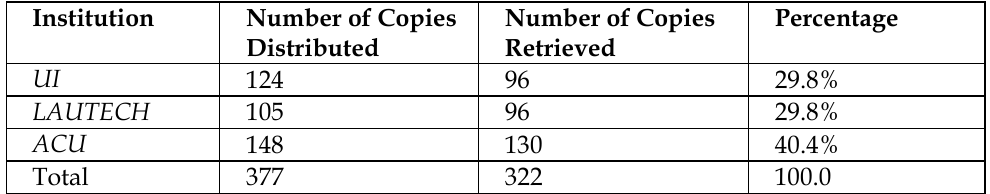
Table 3: Copies of questionnaire retrieved